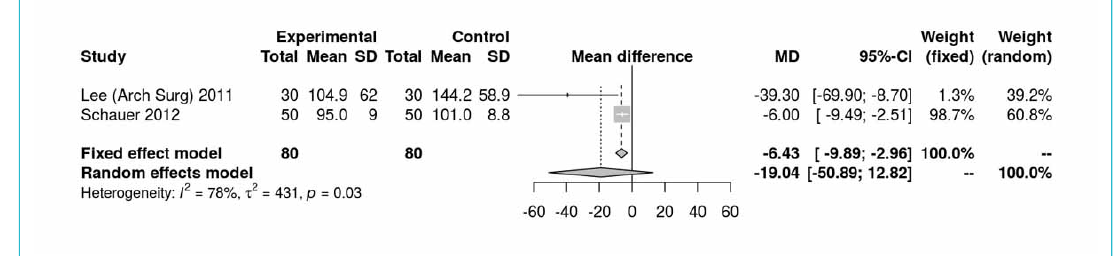
Figure S6q: Triglycerides at 12 months (analysis of studies including only patients with type 2